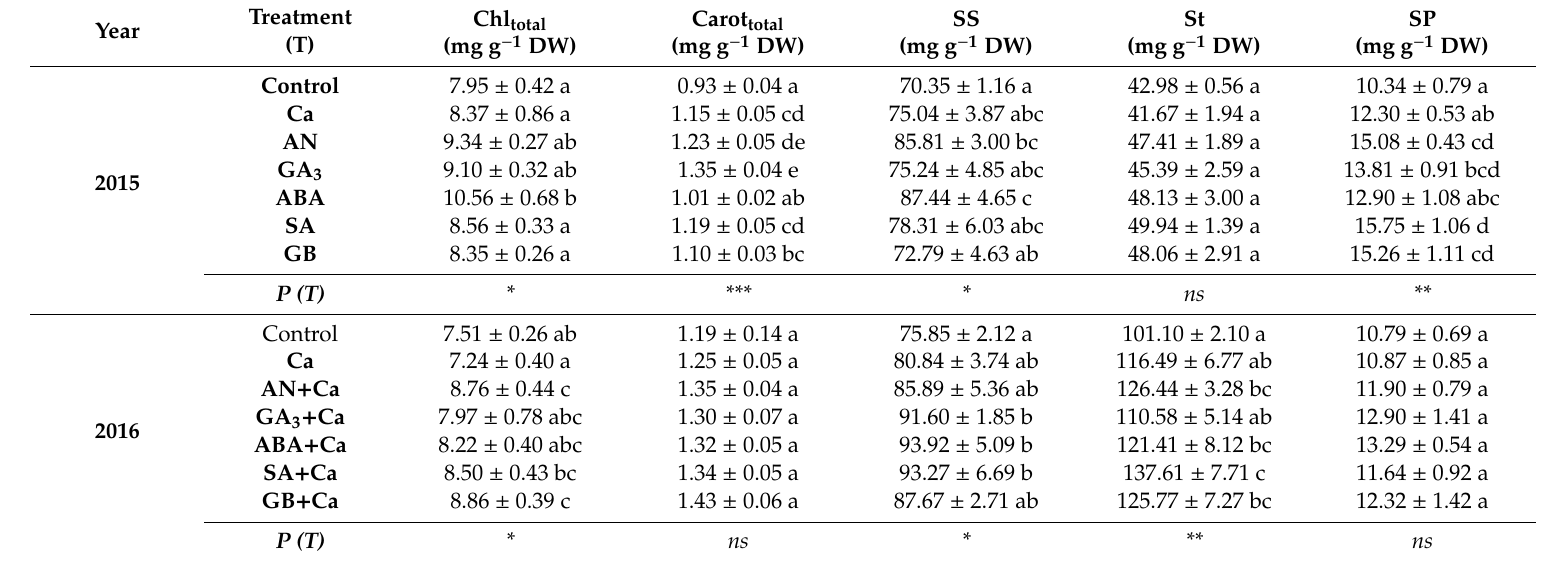
Table 1. Total chlorophyll content (Chl total ), total carotenoids content (Carot total ), soluble sugars content (SS), starch content (St), and soluble protein content (SP) of ‘Skeena’ leaf cherry after spray treatments application in